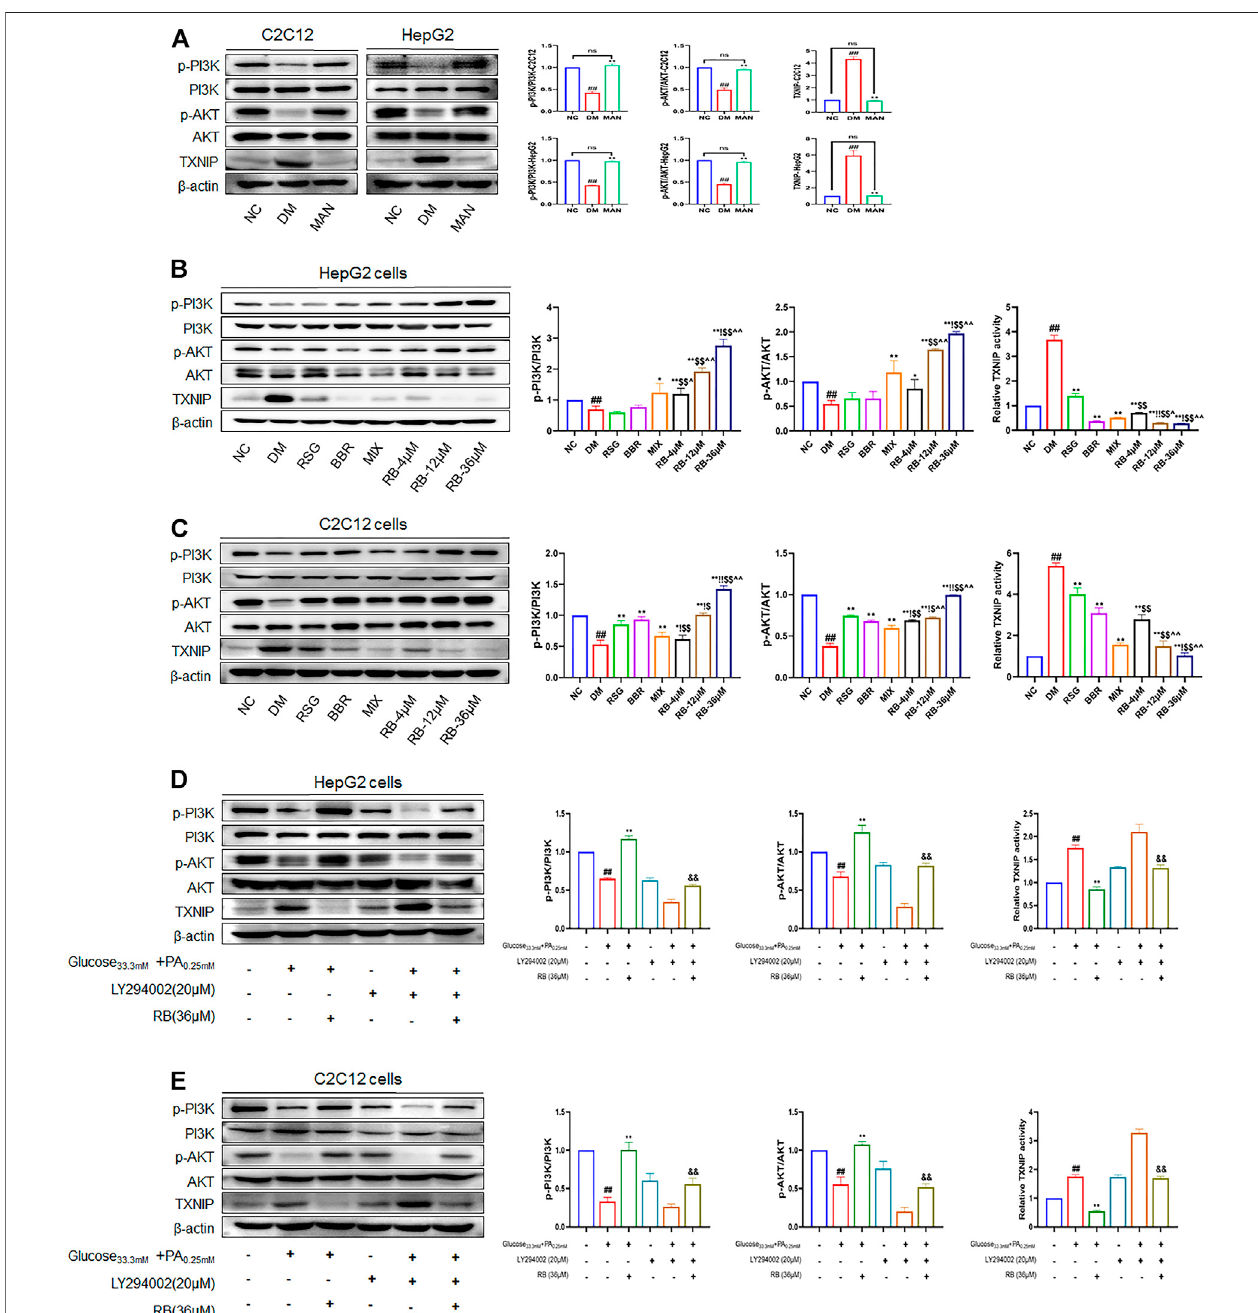
FIGURE 6 | RB ameliorated insulin resistance by upregulating the PI3K/AKT/TXNIP cascade signaling pathway in vitro . (A) Effect of MAN on the expression of p-PI3K, PI3K, p-AKT, AKT, and TXNIP proteins in C2C12 and HepG2 cells; (B) Effect of RB on the expression of p-PI3K, PI3K, p-AKT, AKT, and TXNIP proteins in HepG2 cells; (C) Effect of RB on the expression of p-PI3K, PI3K, p-AKT, AKT, and TXNIP proteins in C2C12 cells; (D) Effect of PI3K inhibitor LY294002 (20 μ M) on the expression of p-PI3K, PI3K, p-AKT, AKT, and TXNIP proteins in HepG2 cells; (E) Effect of PI3K inhibitor LY294002 (20 μ M) on the expression of p-PI3K, PI3K, p-AKT, AKT, and TXNIP proteins in C2C12 cells. All data are expressed as the mean ± SD of three independent experiments. # p < 0.05, ## p < 0.01, vs. NC group; * p < 0.05,** p < 0.01,vs.DMcontrolgroup; $ p < 0.05, $$ p < 0.01,vs.RSGgroup; ^ p < 0.05, ^^ p < 0.01,vs.BBRgroup; ! p < 0.05, !! p < 0.01,vs.MIXgroup; & p < 0.05, && p < 0.01, vs. RB group; ns, no signi fi